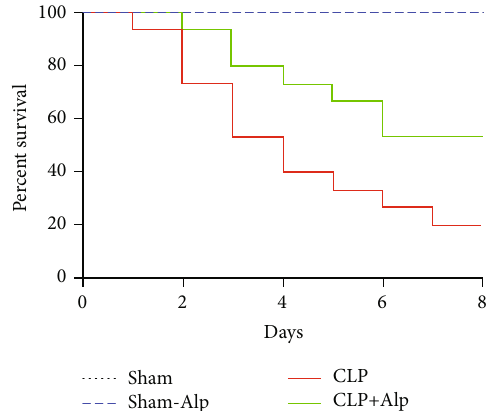
Figure 1: E ff ect of alpinetin on the survival of CLP septic mice. Mice were intravenously administered with alpinetin (50 mg/kg) in the sham+alpinetin and CLP+alpinetin groups, and the survival rates of the mice were monitored for 8 days. Survival data were analyzed using the Kaplan-Meier method, and survival curves were compared using the log-rank test and